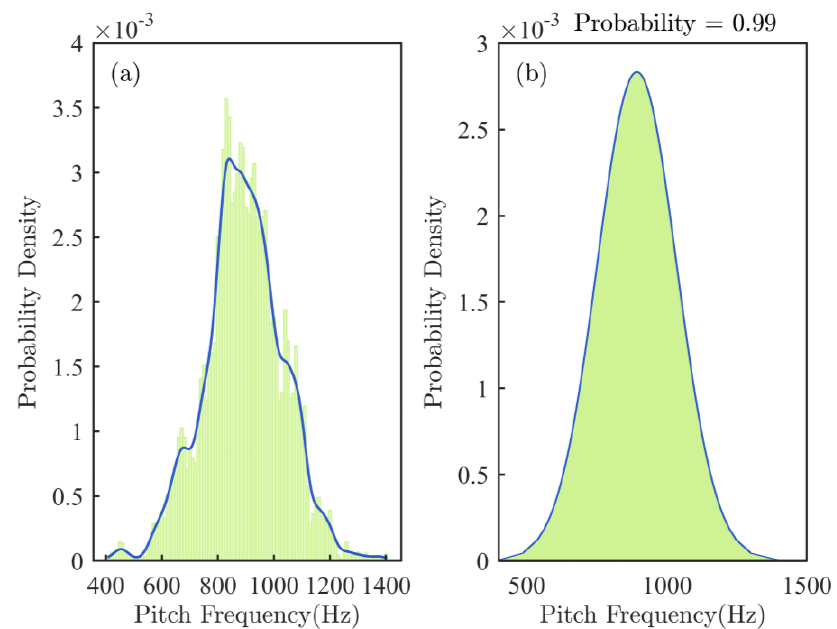
Figure 8. Probability density distribution of the ship engine pitch frequency 𝑆𝑓 𝑝𝑖𝑡𝑐ℎ : ( a ) The vertical axis values of the histogram (green part) indicate the probability of the sample falling in each frequency interval, and the blue curve is the probability distribution fitting curve; ( b ) the probability value (shaded green area) calculated using autonomous programming.